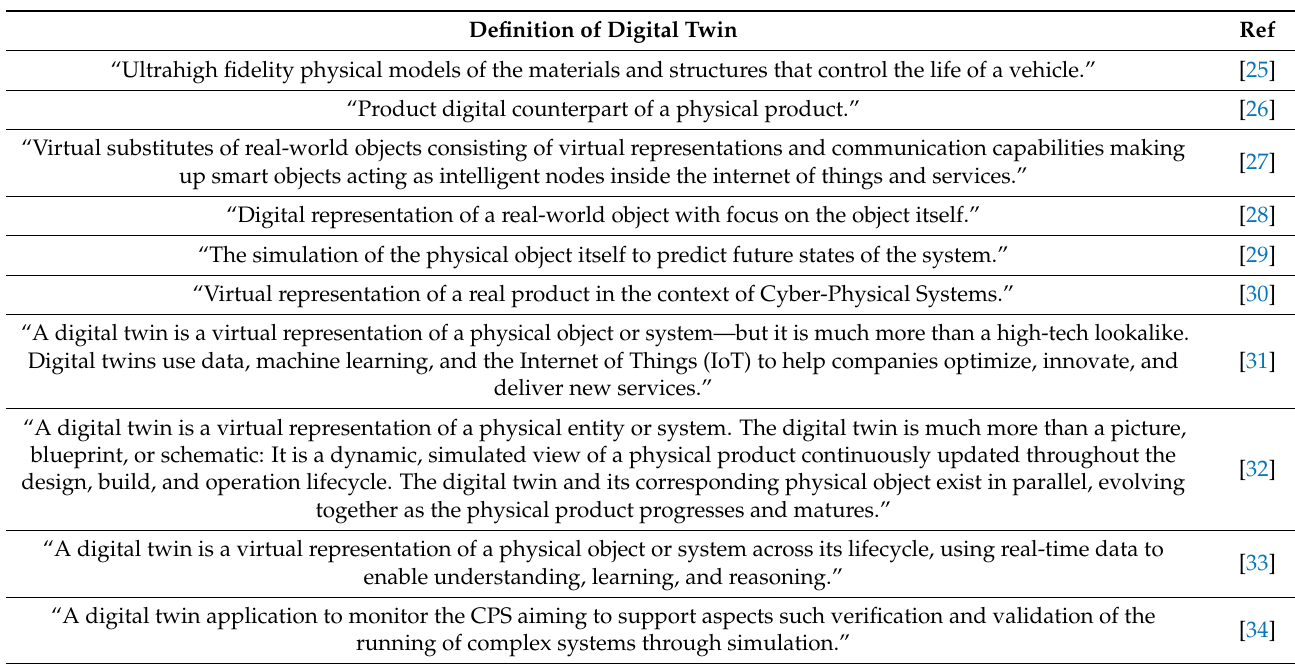
Table 1. Definitions in the